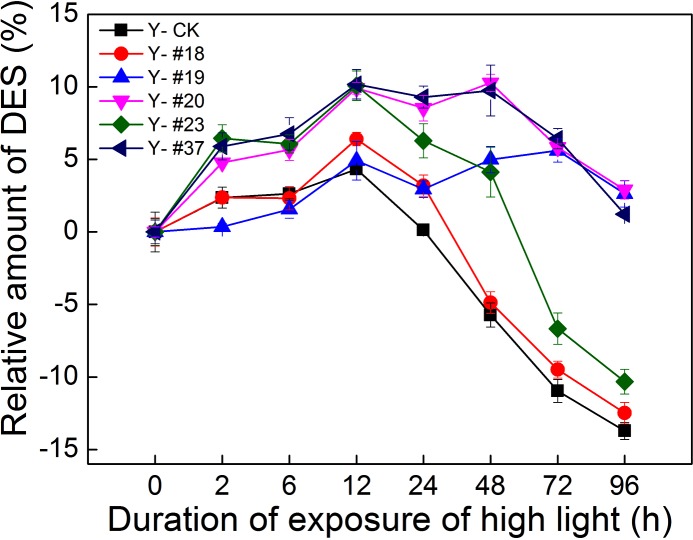
Relative amount of DES in the progenies and in the control group under HL exposure.The concentrations of Vx, Ax and Zx were measured by HPLC. DES = (Zx+0.5Ax)/(Vx+Ax+Zx). The five progenies and the control group were grown under HL exposure (300–400 μmol photons m-2 s-1) for 96 h. Each experimental HL exposure value was compared with the value found under normal conditions (0 h). n = 3+SD.